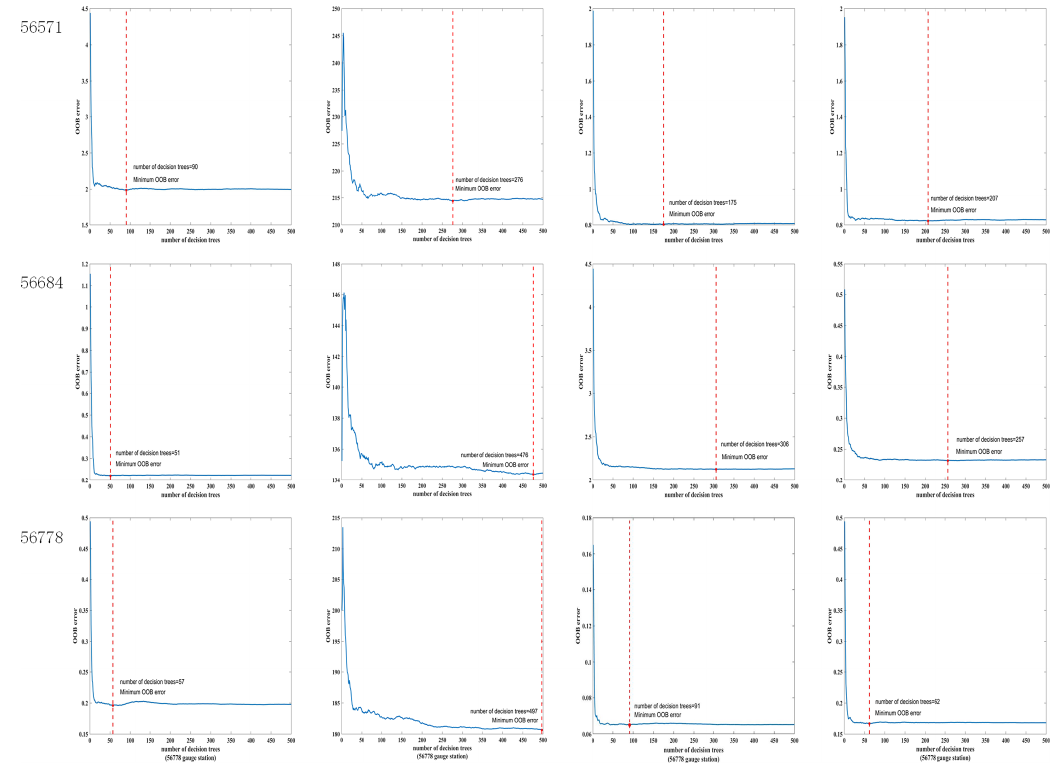
Figure C1. Changes in the out-of-bag (OOB) error with increasing number of decision trees by means of random forest regression at each gauge